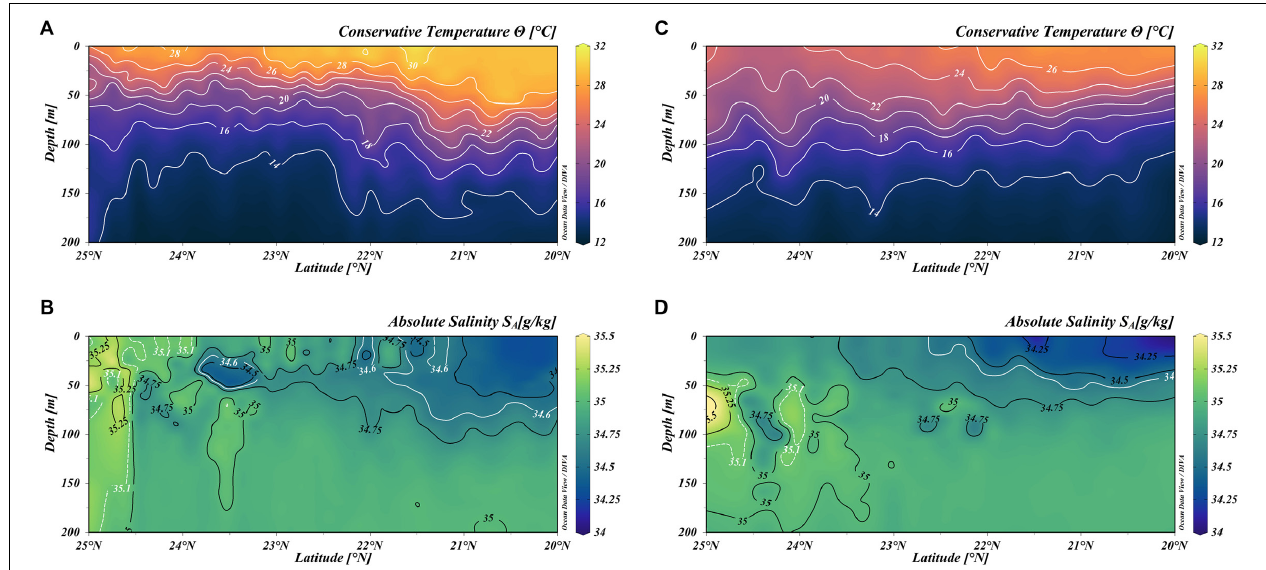
FIGURE 3 | Vertical distribution of conservative temperature ( (cid:50) , ◦ C) and absolute salinity (S A , g/kg) over transect 1 (see Figure 1 ). Respectively, (A,B) correspond to June 2015 and (C,D) to March 2016. Isohaline limits for Tropical Surface Water and Californian Current Water ( < 34.6 g/kg) and Gulf of California Water ( > 35.1 g/kg) appear in